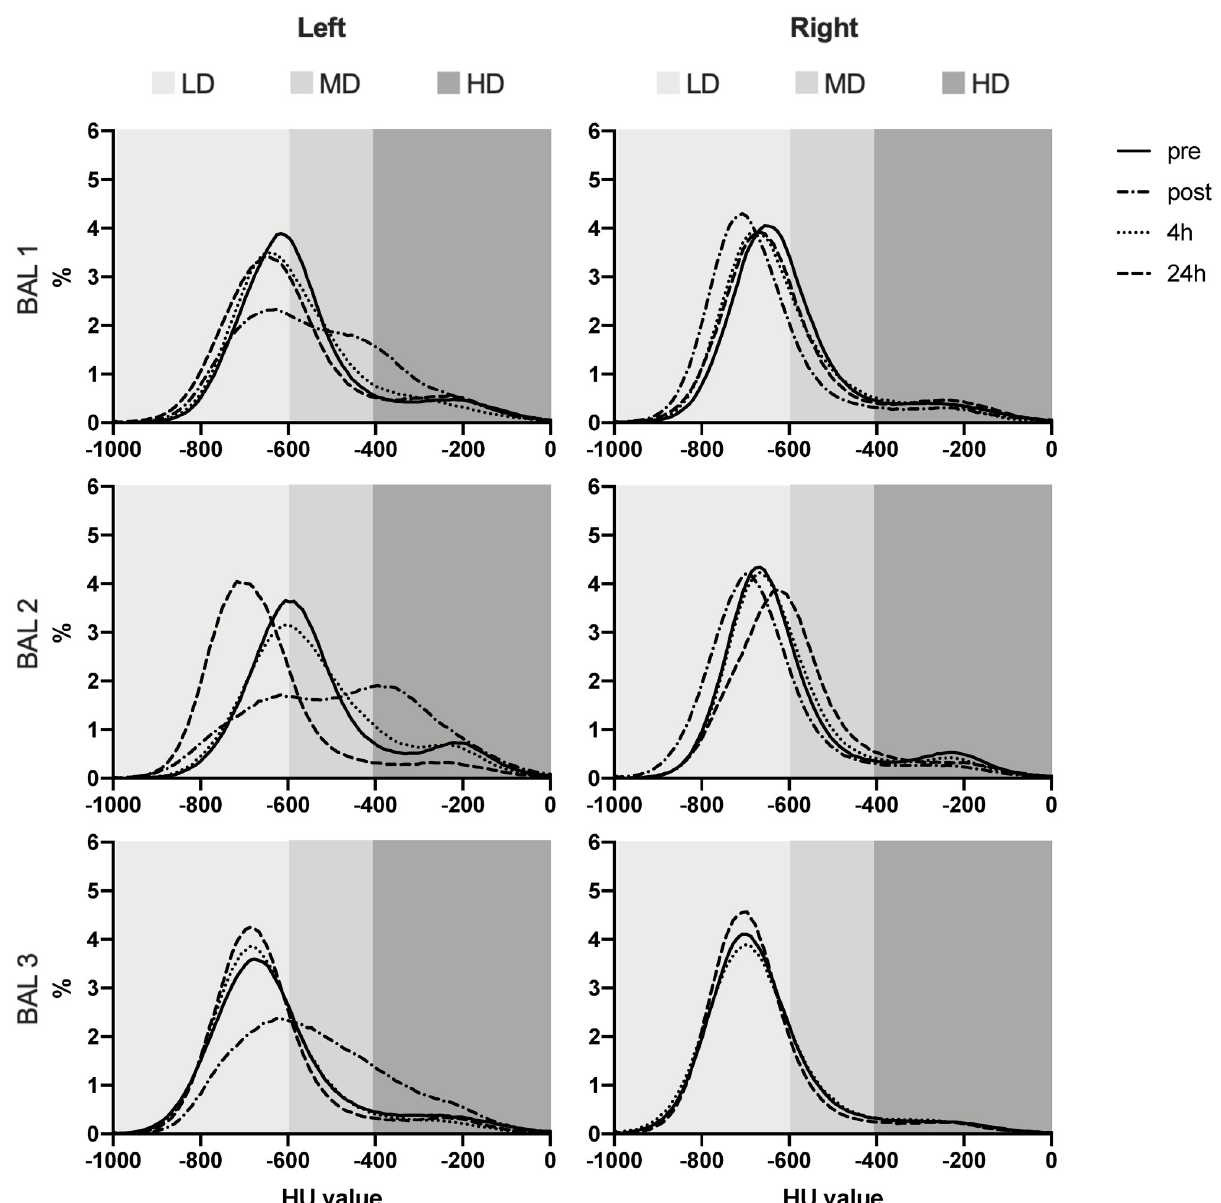
Fig 3. Histograms representing the relative lung density pattern of the left and right lung of one representative (RM3) of the non-infected group. LD = -1000/-600 HU, healthy lung, MD = -600/-400 HU, HD = -400/0 HU, non-healthy lung.